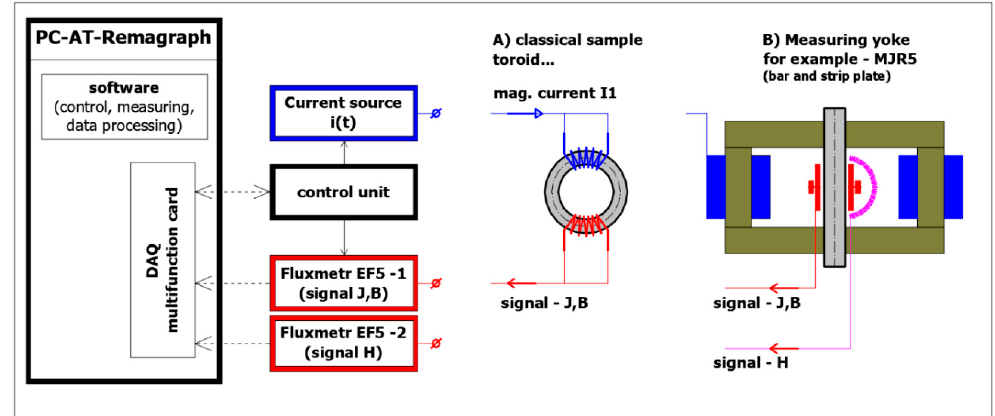
Figure 2. Photographic images of the testing samples for the magnetic properties measurement, ( A )—Samples after 3D printing, ( B )—Samples with winding configuration.